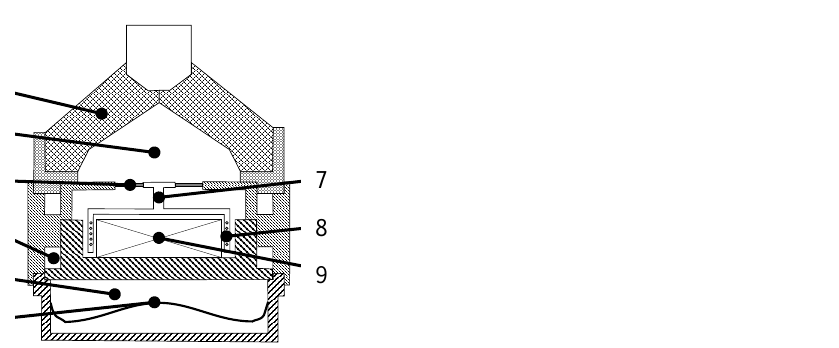
Figure 1. Configuration schematics for the AHM-IT-DM-OCA [22]: 1. rubber bellow; 2. lower chamber; 3. inertia track; 4. decoupler membrane; 5. upper chamber; 6. main rubber spring; 7. actuator mover; 8. coil; 9. permanent magnet.